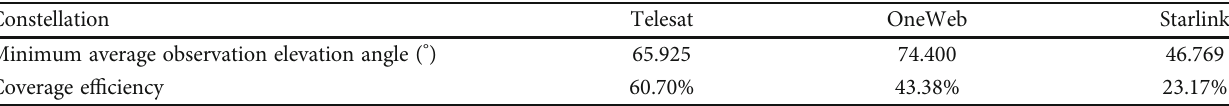
Figure 6: Distribution characteristics of observation elevation angles of typical constellations. Table 3: Typical constellation performance index